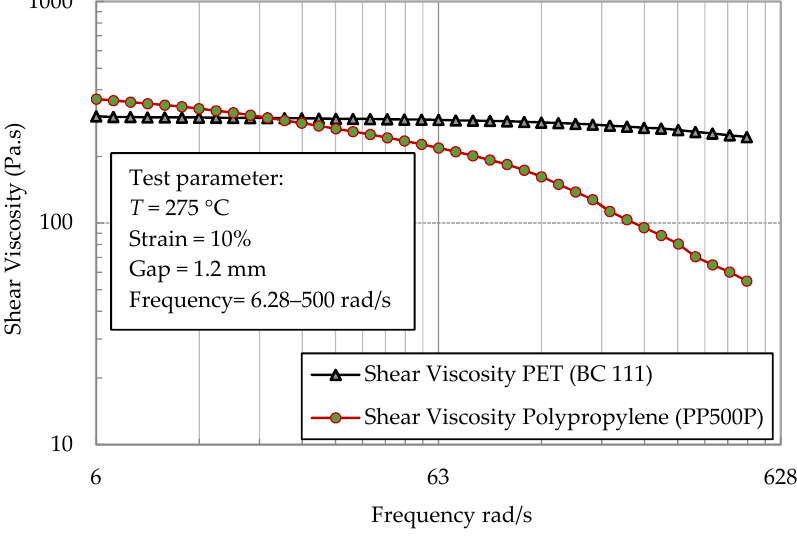
Figure 2. Rheology of PP and PET polymers.